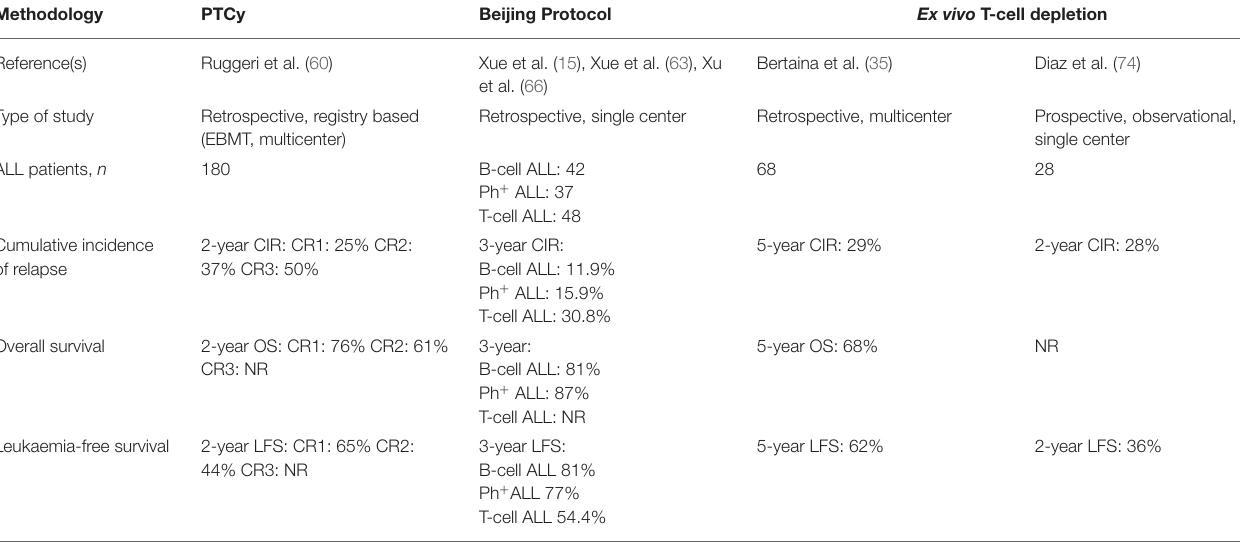
TABLE 1 | Summary of the largest studies assessing outcomes of haploidentical HSCT in paediatric patients with ALL, according to T-cell-depletion methodology used.